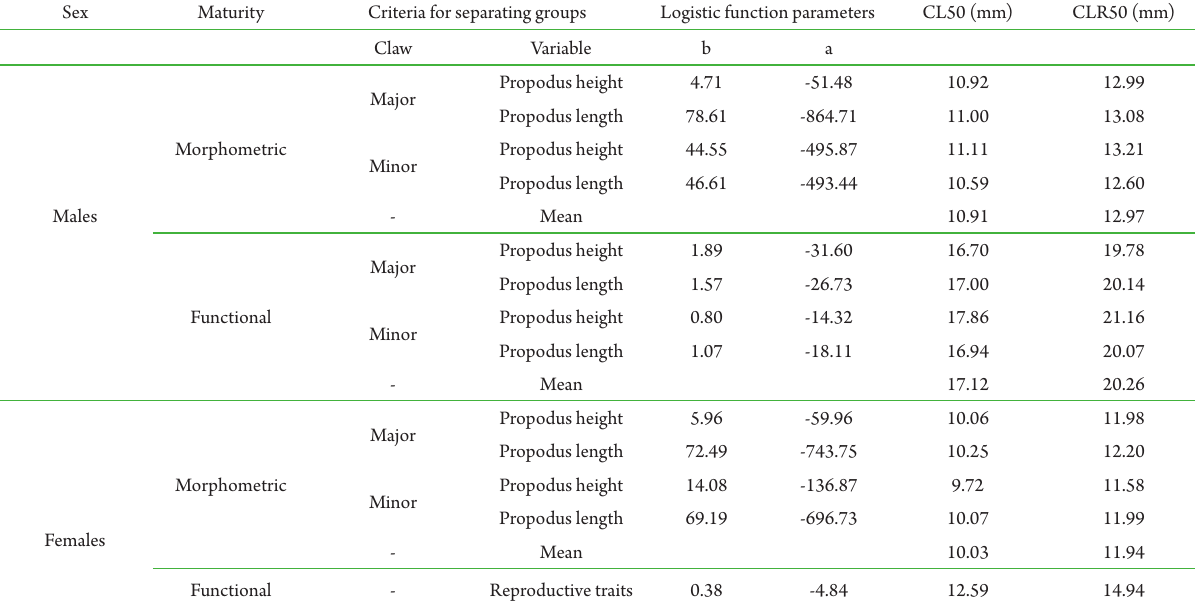
Table 3. Size at onset of morphometric and functional maturities males and females of Aegla castro . Parameters of the logistic function fitted in each analysis are